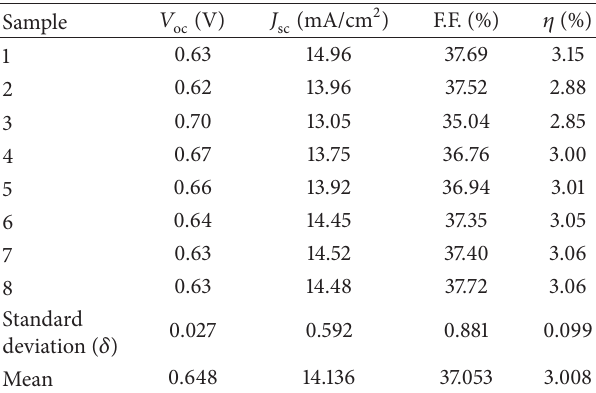
Table 1: Photovoltaic properties of